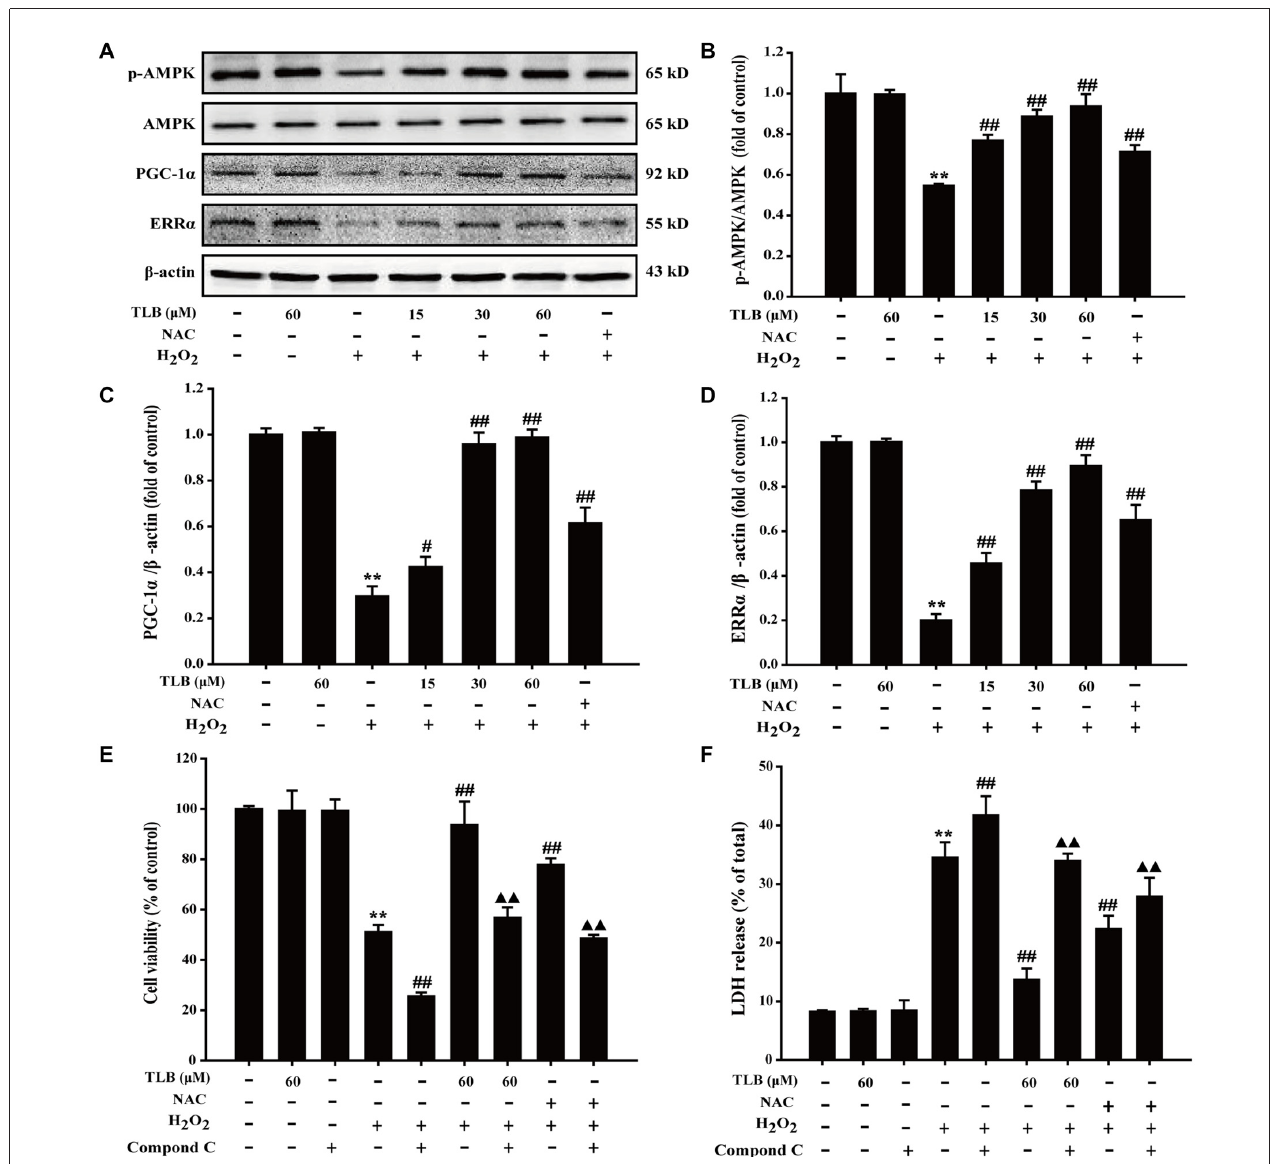
FIGURE 5 | The role of adenosine monophosphate-activated protein kinase (AMPK) signaling pathway in the protective effect of TLB on H 2 O 2 -induced PC12 cells injury. (A) Representative Western blot were shown for AMPK, peroxisome proliferator-activated receptor gamma coactivator 1-alpha (PGC-1 α ) and ERR α proteins. (B) Quantitation of phosphorylation of AMPK protein. The relative optical density was normalized to AMPK. (C) Quantitation of PGC-1 α protein. (D) Quantitation of ERR α protein. AMPK-specific inhibitor significantly abolished the protective effect of TLB. (E) Cell viability was determined using MTT assay. (F) LDH release was determined using an LDH release assay. Data were presented as mean ± SD of three independent experiments. ∗∗ P < 0.01 vs. untreated control cells; # P < 0.05, ## P < 0.01 vs. H 2 O 2 -treated cells; (cid:78)(cid:78) P < 0.01 vs. TLB + H 2 O 2 -treated